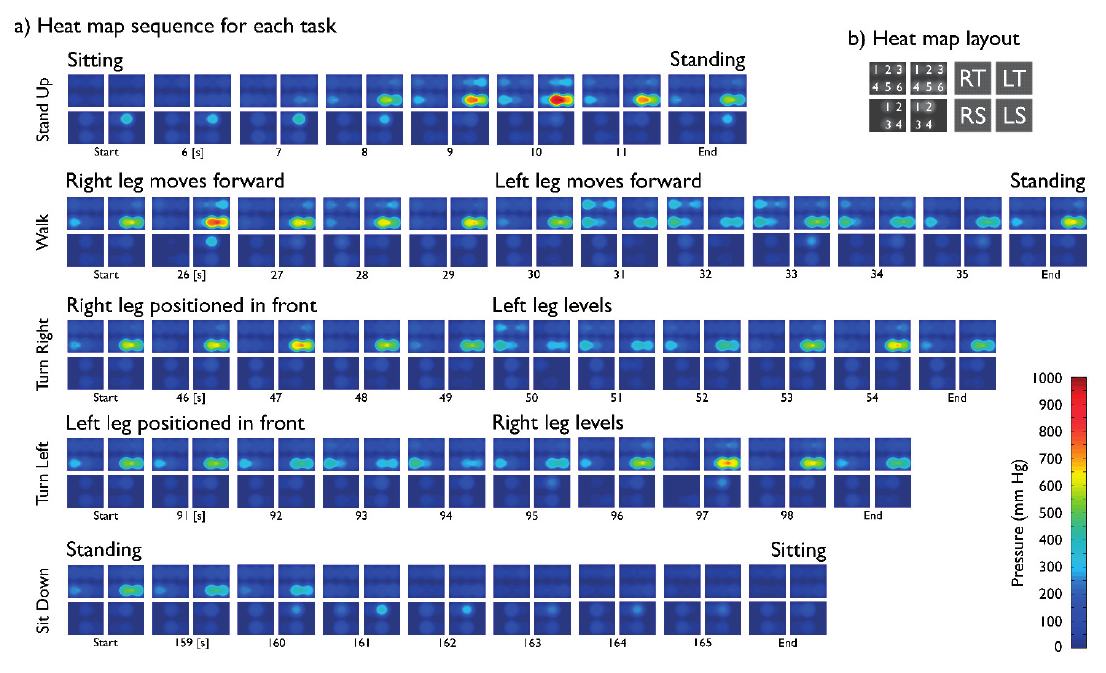
Figure 5. ( a ) Each set of four heat maps corresponds to pressure distribution on both legs for each indicated robot motion during a typical testing protocol. Data corresponds to that shown on Figure 4. Greater tension in the lower strap adjusting the subject’s Left Thigh is evident. Pressure is consistently greater in subject’s thighs, suggesting straps on the upper leg support most of the exoskeleton’s user’s weight. Pressure increases on Shins in sitting position. As the trial advances, base pressure on the legs appears to drop: compare “End” heat maps for the first four tasks, all corresponding to standing position; ( b ) Diagram used for heat map interpretation. RT: Right Thigh; LT: Left Thigh; RS: Right Shin; LS: Left